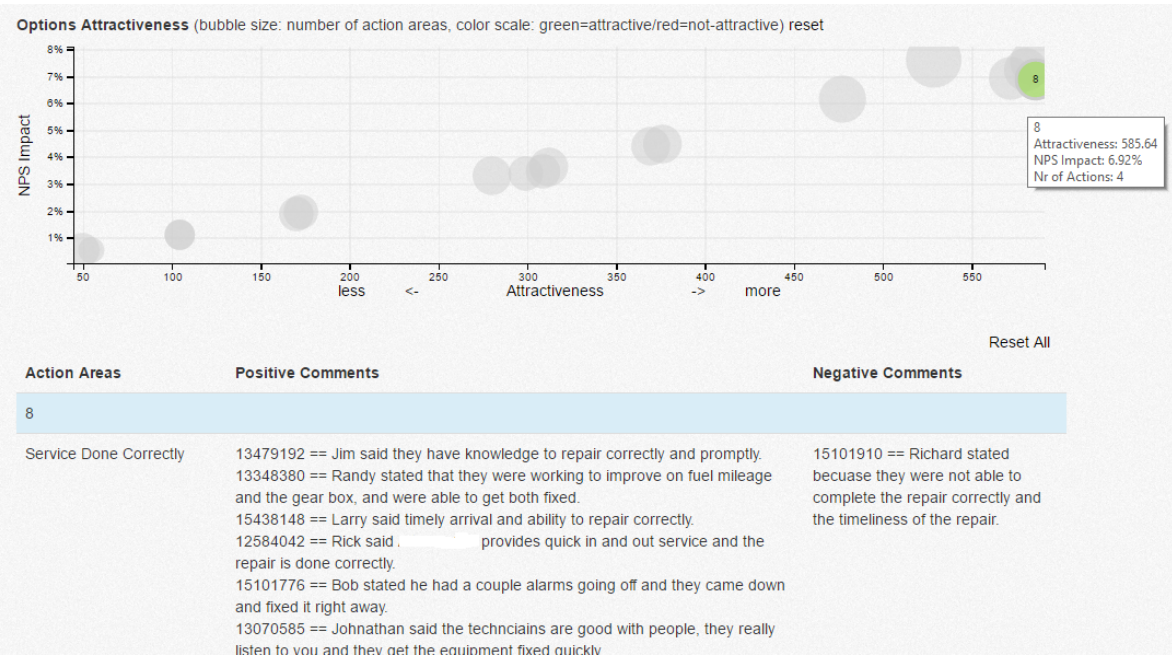
Figure 8. CLIRS2-Customer Loyalty Improvement Recommender System adopted to generate recommendations based on qualitative customer feedback.